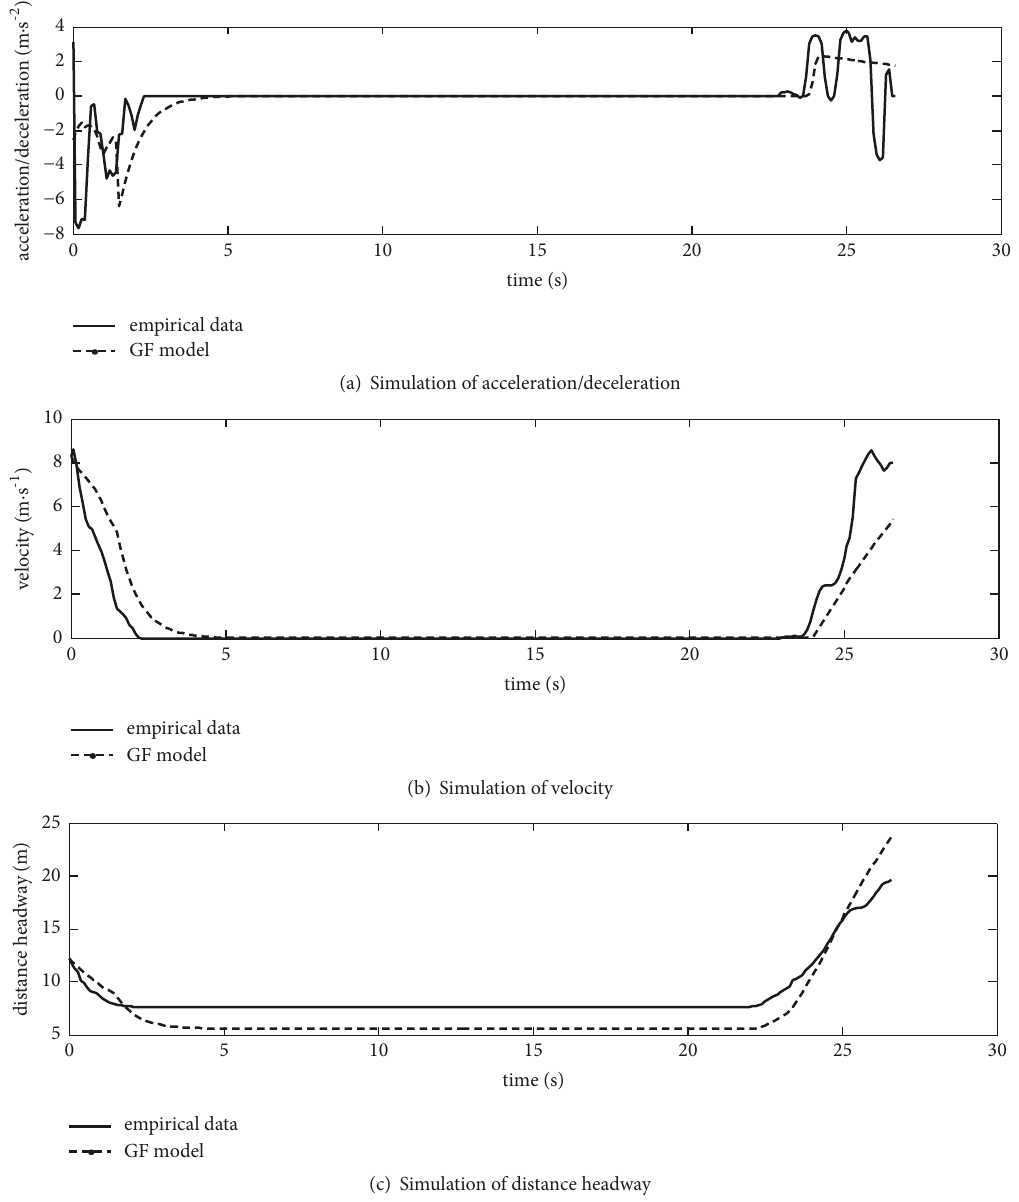
Figure 6: GF model simulations of car-following Process